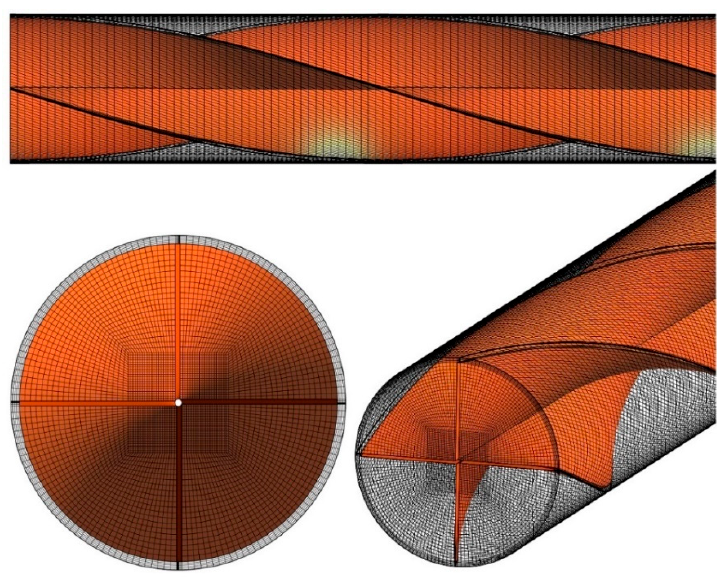
Figure 2. The computational mesh for Case 5.